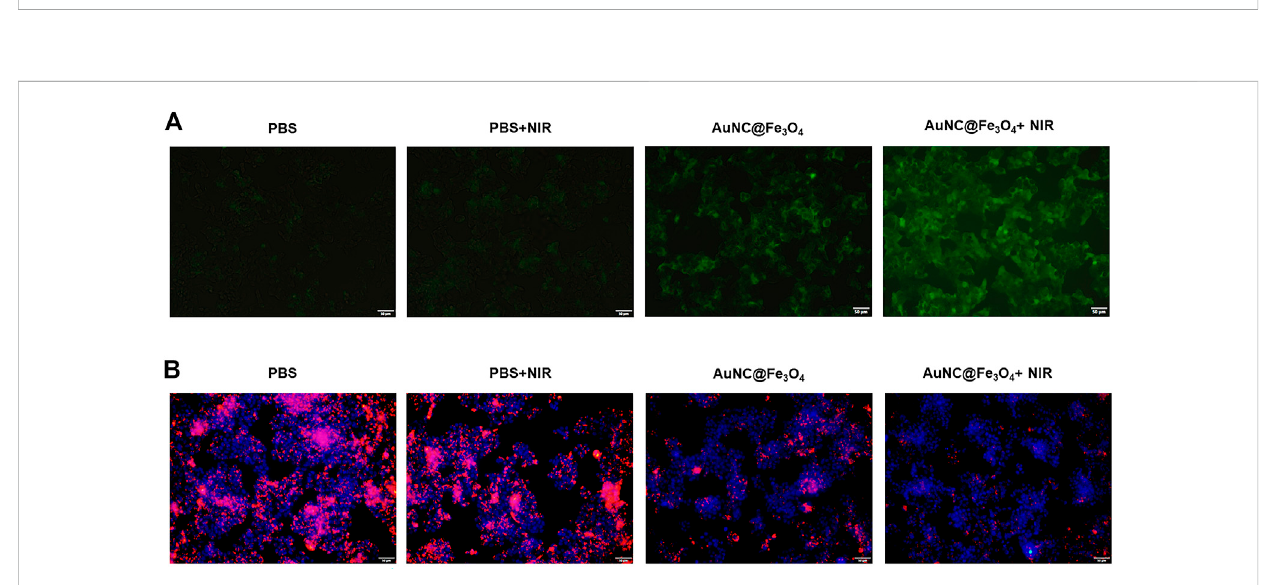
FIGURE 5 Analysis for synergistic effect of photothermal therapy (PTT) and catalytic activity of AuNC@Fe 3 O 4 . (A) Reactive oxygen species (ROS) detection of HepG2 cells with varying treatments. (B) Lysosomal impairment detection of HepG2 cells with varying treatments. Scale bar: 50 μ m.